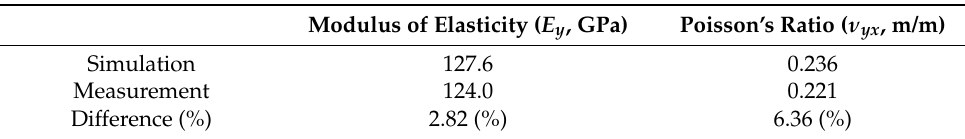
Table 9. Difference between simulation and measurement for Type II.